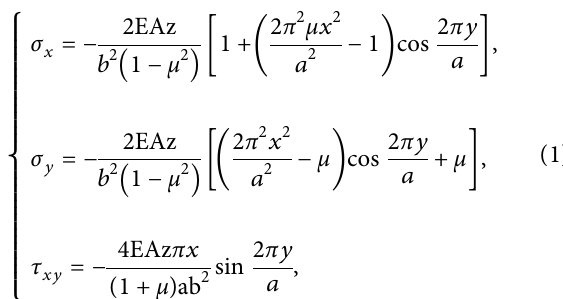
where σ , E , A , and b represent the normal stress (MPa) x acting vertically on the x -axis plane, elastic modulus (MPa) of roof rock, coefficient of the deflection surface, and length (m) of the working face, respectively; μ , a , and σ